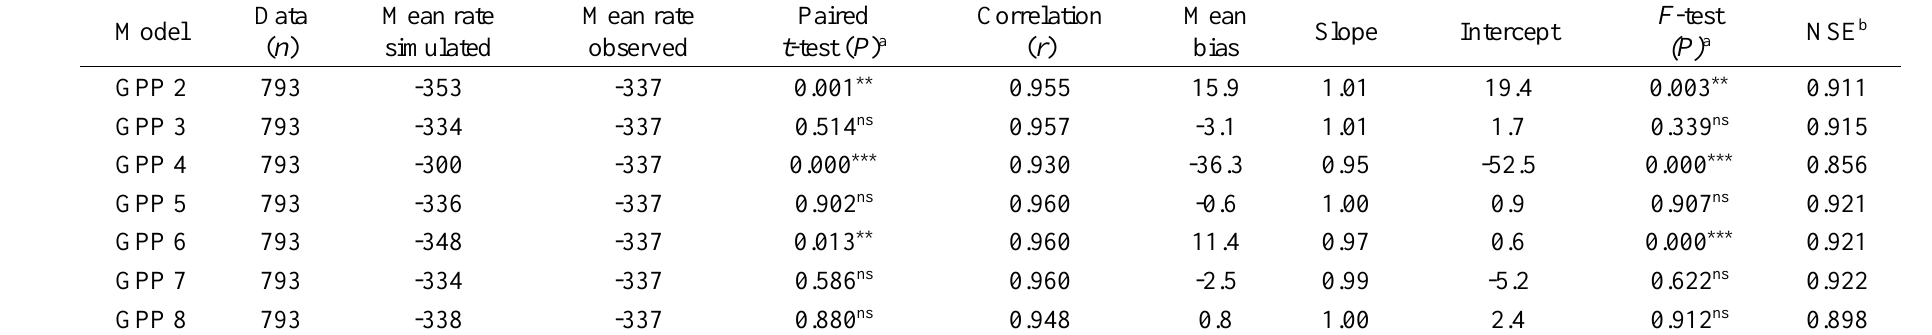
Table A6. Model performance statistics for gross primary production (GPP) models fitted to data from control (C) treatments.